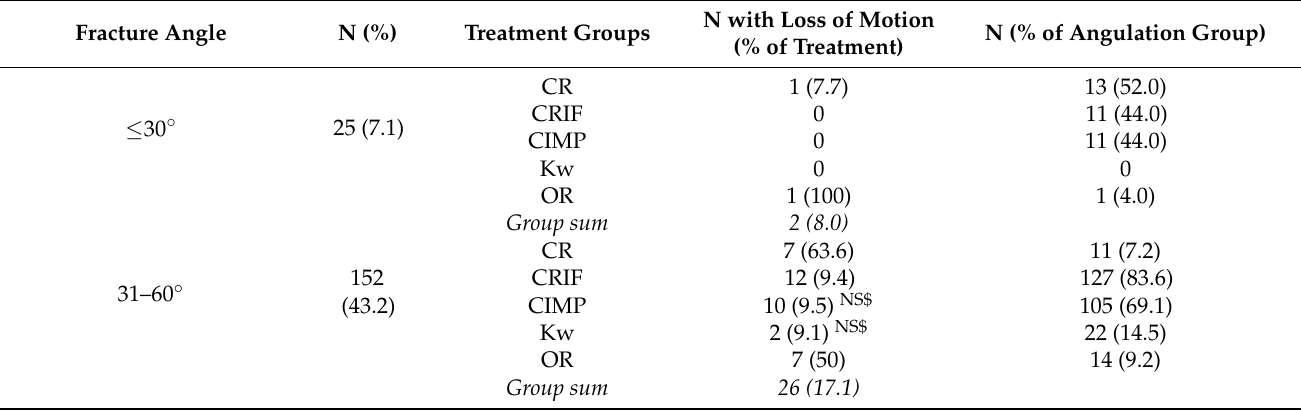
Table 4. Data analysis of 352 pediatric patients who sustained a radial neck fracture and had at least 1 year